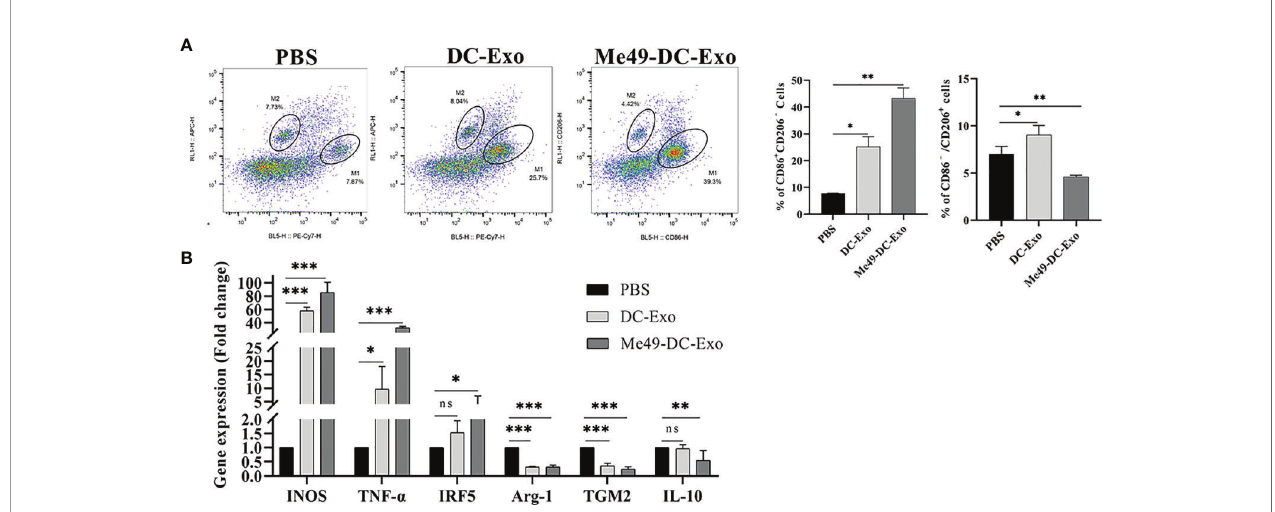
FIGURE 4 | Regulation of macrophage polarization by Me49-DC-Exo. (A) CD86 + CD206 – M1 and CD86 – CD206 + M2 macrophages were detected by fl ow cytometry, and the percentage of CD86 + CD206 − / CD86 − CD206 + positive macrophages was quanti fi ed. (B) The expression levels of characteristic genes of M1 and M2 macrophage in Raw264.7 cells treated with exosome were analyzed by qRT-PCR. ns ( p ≥ 0.05), * p < 0.05, ** p < 0.01, *** p < 0.001.